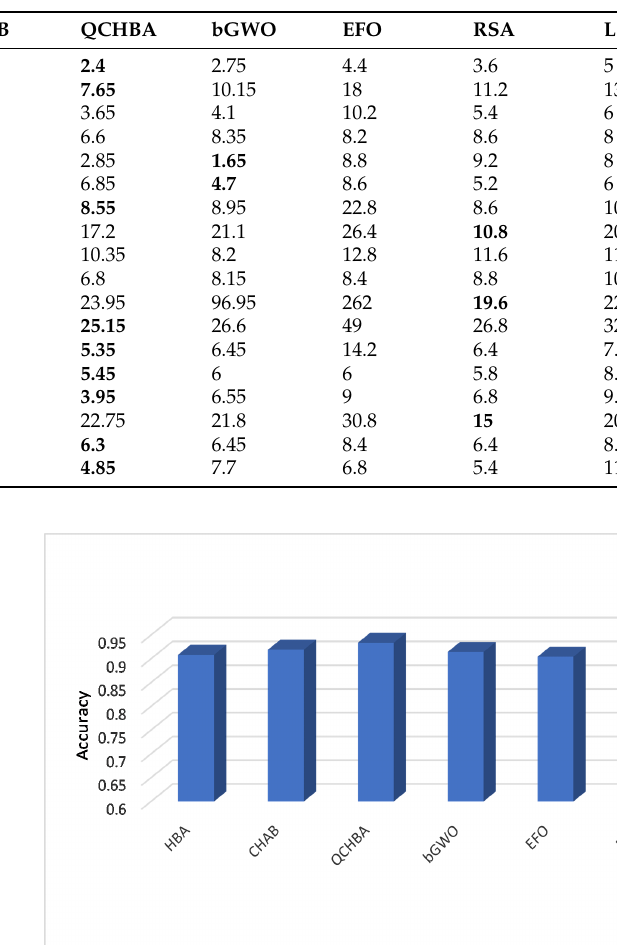
Table 7. Number of selected features.